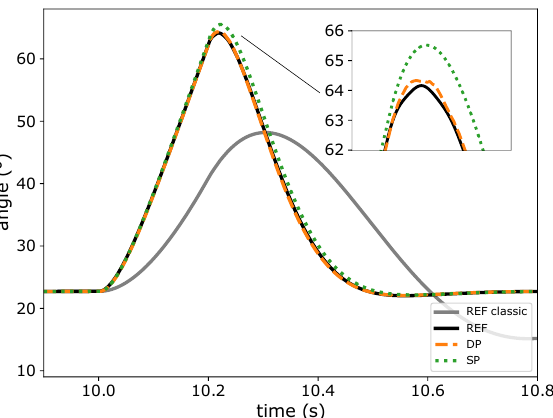
Figure 9. SG rotor angle transient with lower inertia considering a characteristic simulation step size of